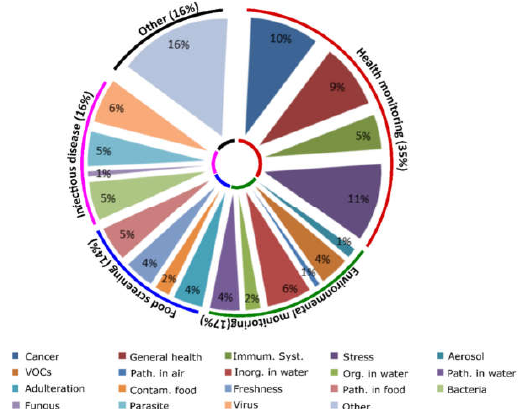
Figure 1. Classification of relevant SBD related literature. A pie chart showing the classification of the 148 articles kept for thorough analyses after the keyword searches. Groups (outer circle) are divided into subgroups (inner pie chart). Percentages indicate percentage of articles presenting the group or subgroup in relation to the total amount of articles kept for analyses.